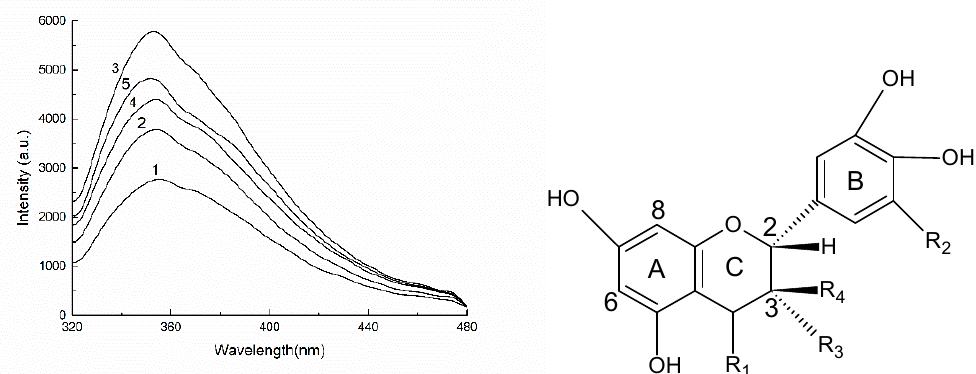
Figure 10. Effect of solvent polarity on fluorescence intensity of LOPC. Ethanol concentration: 1, 5%; 2, 25%; 3, 50%; 4, 75%; 5, 100%.